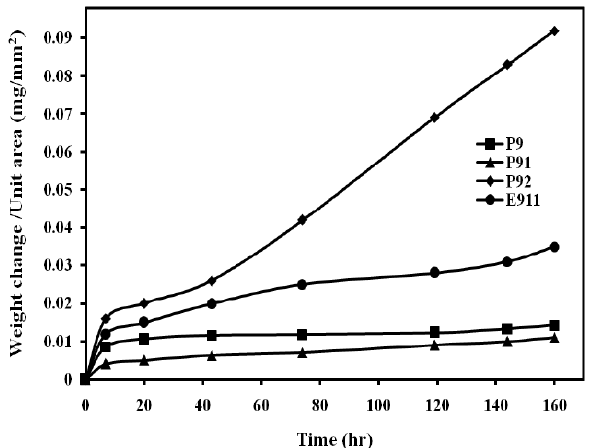
Figure 8. Weight change vs. time plots for alloys oxidized at 973 K in O 2 + 50 % H 2